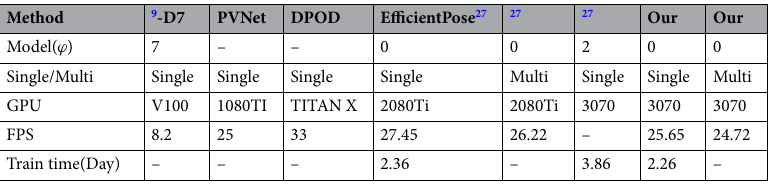
Table 4. End-to-End runtime results.